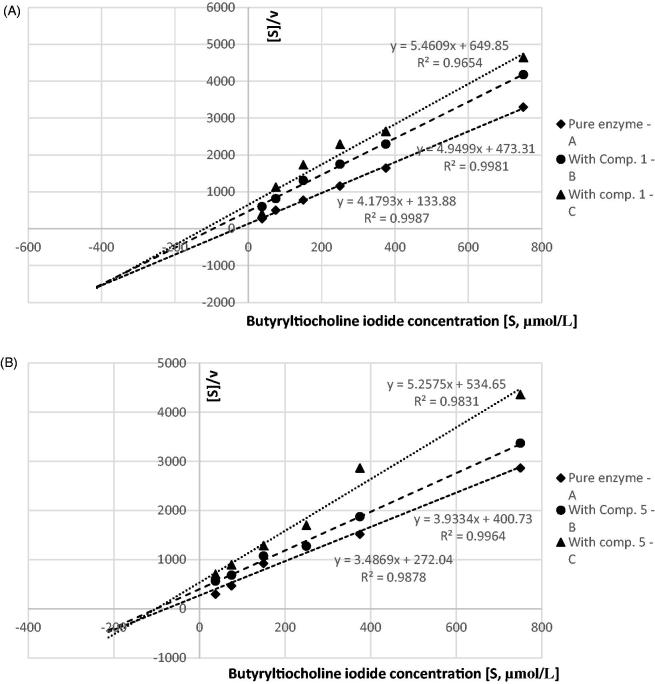
Determination of kinetic parameters of BuChE enzymatic reactions. Hanes–Woolf plots we used to calculate the Michaelis constant (Km) and maximal velocity (Vmax). (A) BuChE and compound 1 at a concentration of 625.0 µmol/L and 1876.0 µmol/L; mixed-type inhibition. (B) BuChE and compound 5 at a concentration of 228.0 µmol/L and 686.0 µmol/L; mixed inhibition. Presented data constitute the results of one exemplary experiment conducted in duplicates. The results of kinetic studies conducted in three independent experiments and calculated kinetic parameters are enclosed in Table 2.